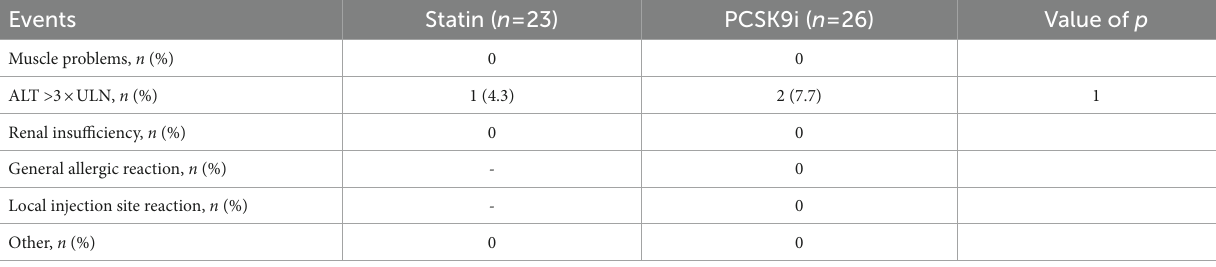
TABLE 5 Adverse